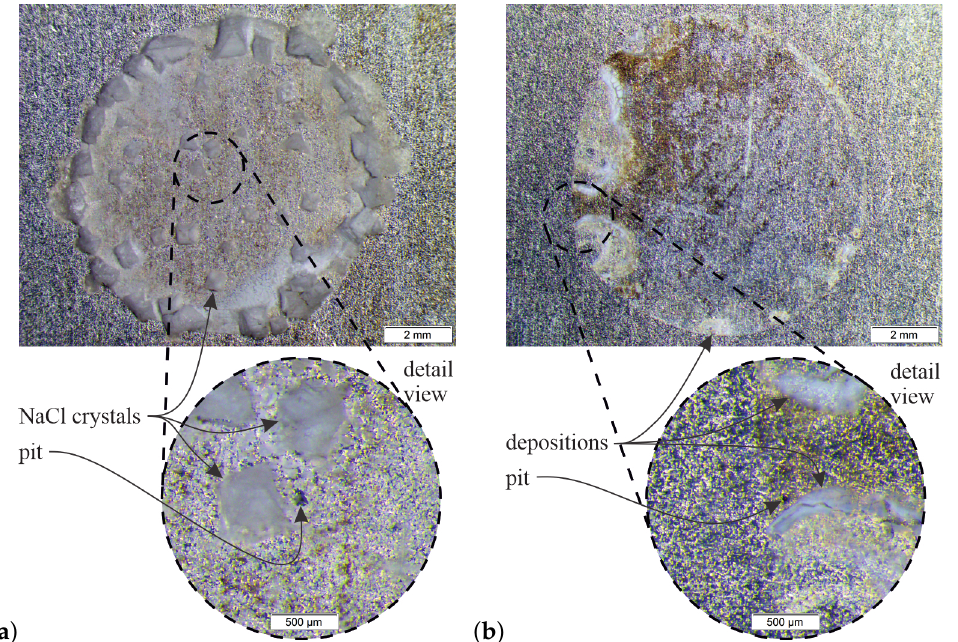
Figure 11. Microscopic images of the corroded surface of the specimen in the AE source identification experiment, i.e., after the evaporation of the droplets of ( a ) the NaCl solution and ( b ) the Milli-Q water. The detailed views show the exemplary pits that